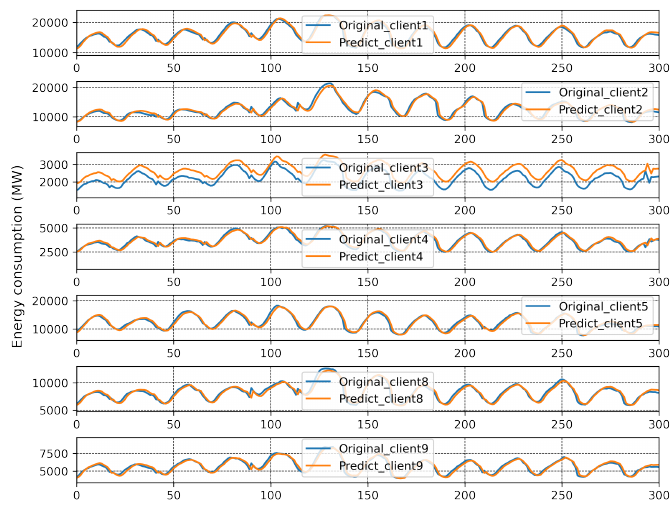
Figure 8. Prediction results of Branch